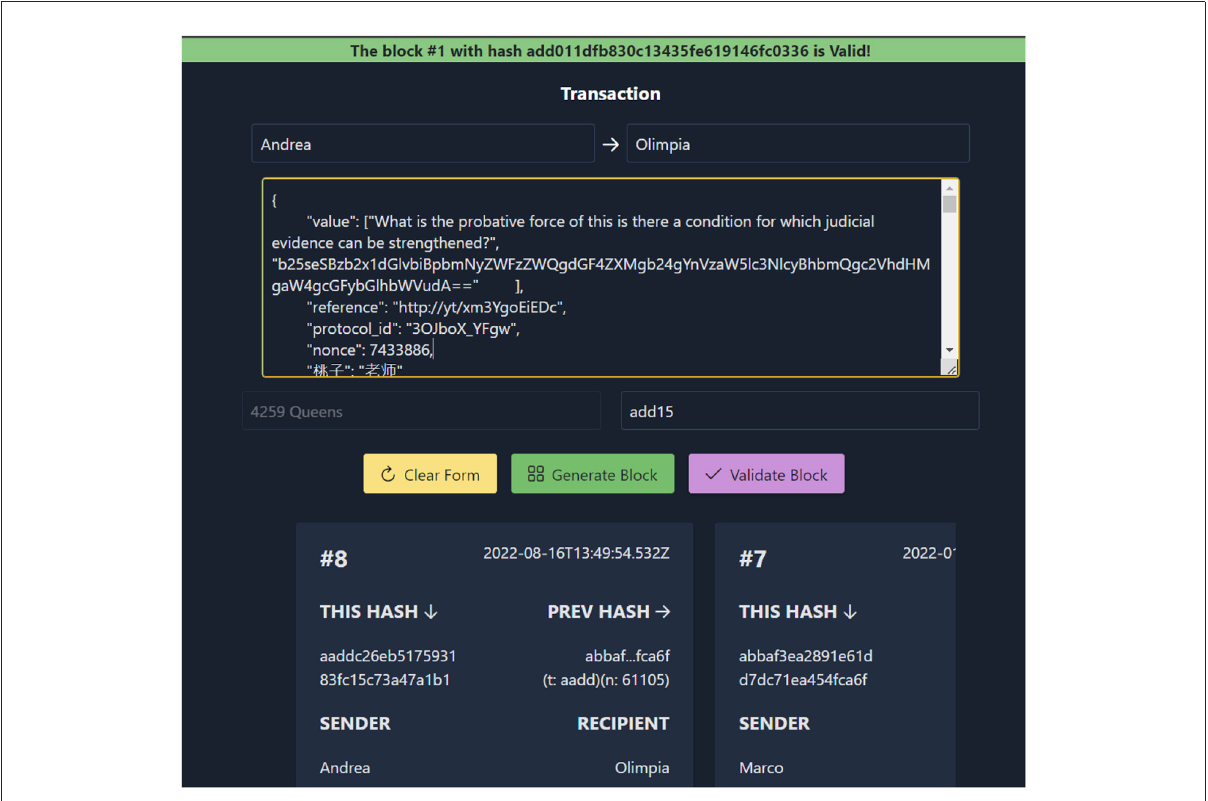
FIGURE6 An example of completely client-side blockchain